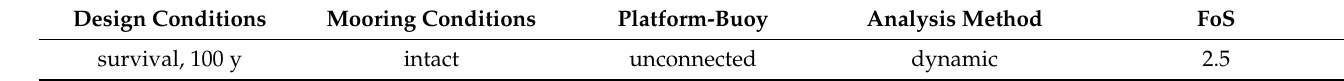
Table 4. Single point mooring line safety factors (WEC platform unconnected).